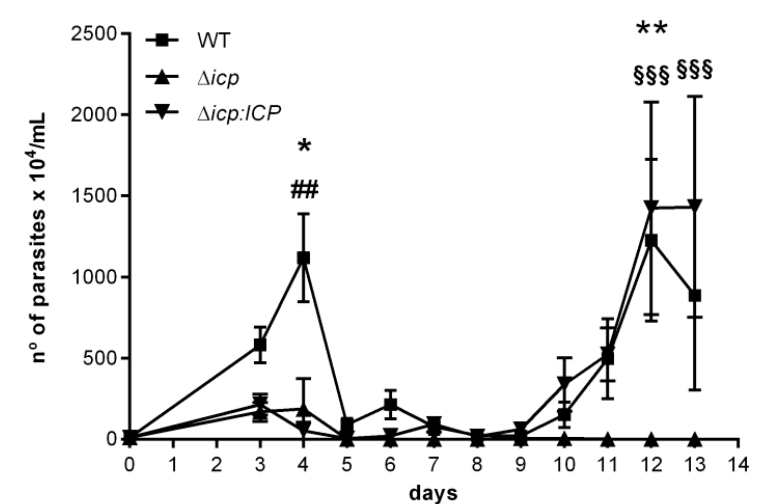
Figure 7. T. b. rhodesiense Δ icp have reduced virulence in C57BL/6 mice. C57BL/6 mice were infected i.p. with BSF parasites of T. b. rhodesiense WT, Δ icp , and Δ icp:ICP (1 × 10 5 parasites per animal) and blood parasitemia was determined from days 3 to 13 of infection (starting with n = 5 per group). The graph shows the mean ±SEM of one experiment and is representative of two independent experi- ments. No mice died over the experimental period. One-way ANOVA with Tukey’s post hoc test was used to determine significant difference between all three groups; where * indicates a significant difference between WT and Δ icp , # between WT and Δ icp:ICP , and § between Δ icp and Δ icp:ICP at p < 0.05 (*), p < 0.01 (** and ##), and p < 0.001 (§§§).